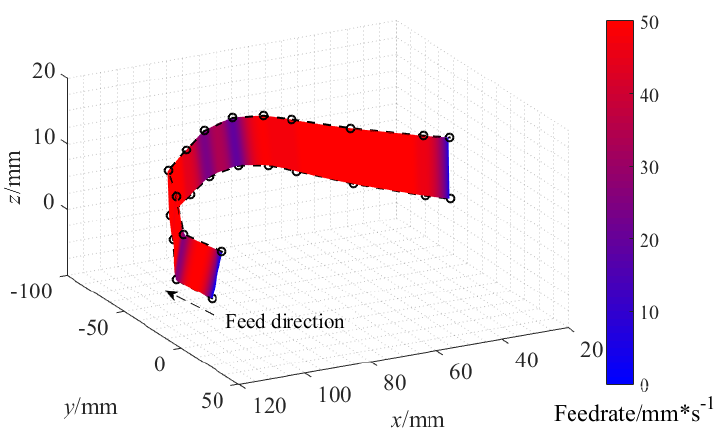
Figure 13. Fitting error and curvature of planar five-point example.